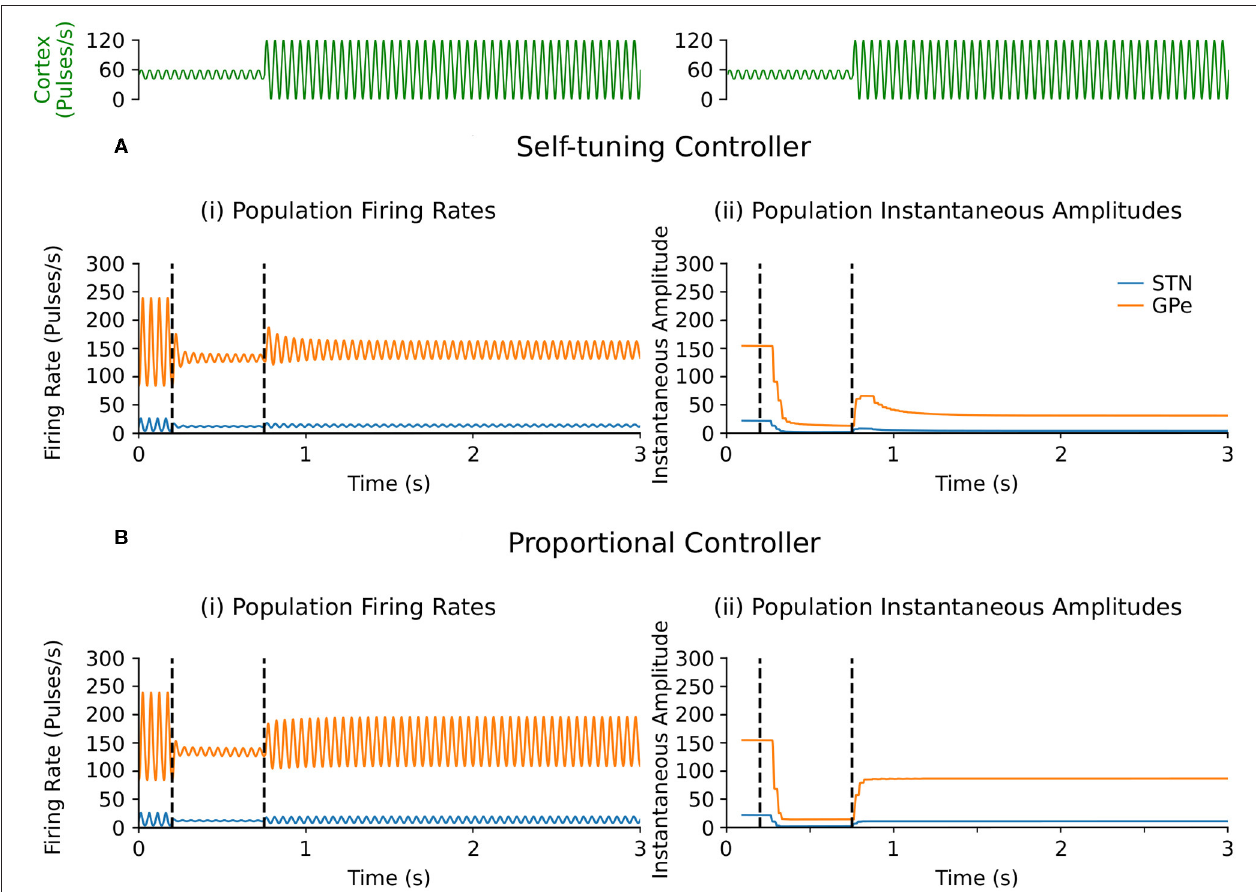
FIGURE 5 | Performance comparison of self-tuning and proportional controllers on exogenous 20 Hz oscillations in the firing-rate model. During simulation, DBS was initially off and then switched on at t = 200 ms, where either the (A) self-tuning controller or (B) proportional controller was implemented. At t = 750 ms, the amplitude of the cortical oscillations was increased from 10 to 60 and the mean level of the oscillations is raised from 50 to 60, amplifying the exogenous oscillations present in the STN and GPe. The cortical input is presented in green at the top of the figure, aligned with respect to the simulation time with the plots underneath. Left panels illustrate the firing rate behavior of the STN and GPe populations and the right panels correspond to the instantaneous peak-to-peak oscillation amplitude of each population (measured with a sliding window of 100 ms) due to either (A) the self-tuning controller (7) with τ θ = 5 ms and σ = 0.01 or (B) the proportional controller (4) with θ =